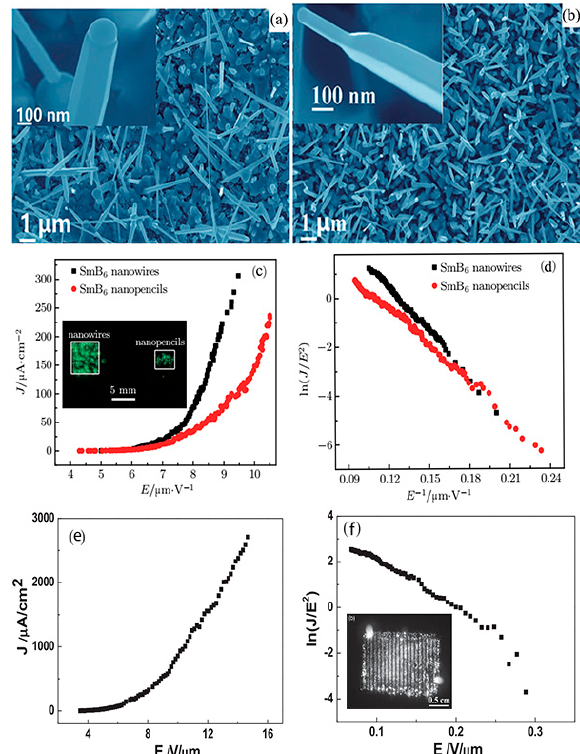
Figure 11. ( a , b ) Top-view SEM images of the SmB 6 nanowires and nanopencils, respectively. The insets are their corresponding high-magnification cross-sectional images. ( c , d ) J–E curves and FN plots of the SmB 6 nanowires and nanopencils. Their emission images are given in the inset [45]. Copyright 2017, IOP Publishing. ( e , f ) Typical J–E curves and FN plots of large-area boron nanowire patterns, and the inset is their corresponding emission image [51]. Copyright 2014, Wiley.